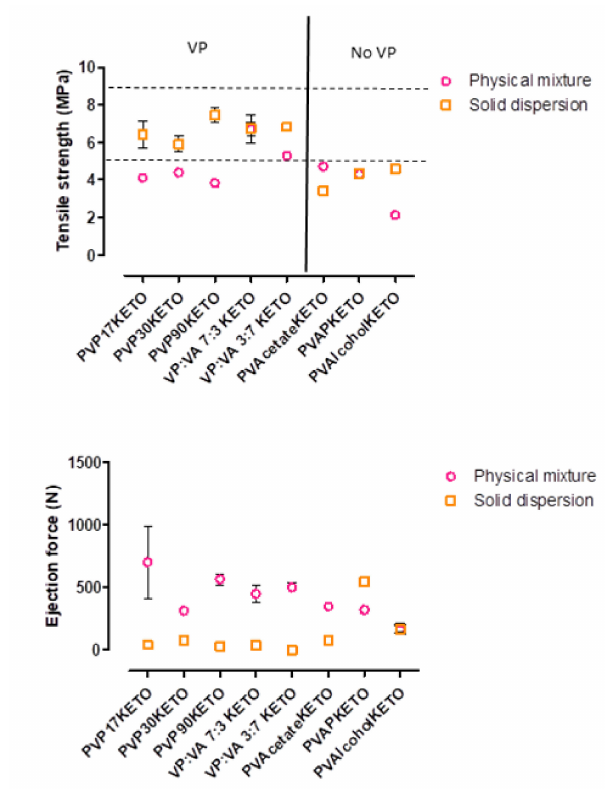
Figure 12. Tensile strength and ejection force of tablets formed from POLYMERKETO solid dispersion systems and equivalent physical